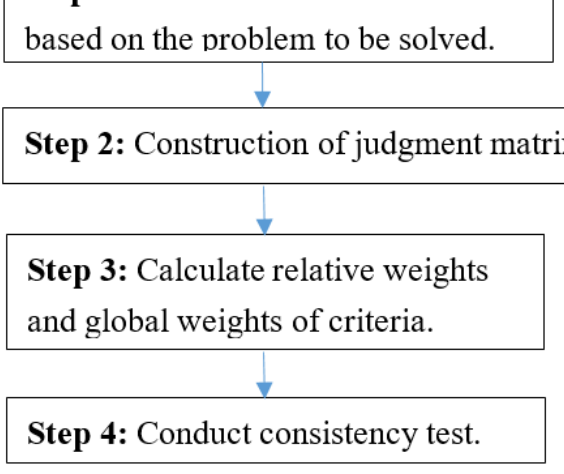
Figure 3. Process of analytic hierarchy process (AHP). Table 3. Random index